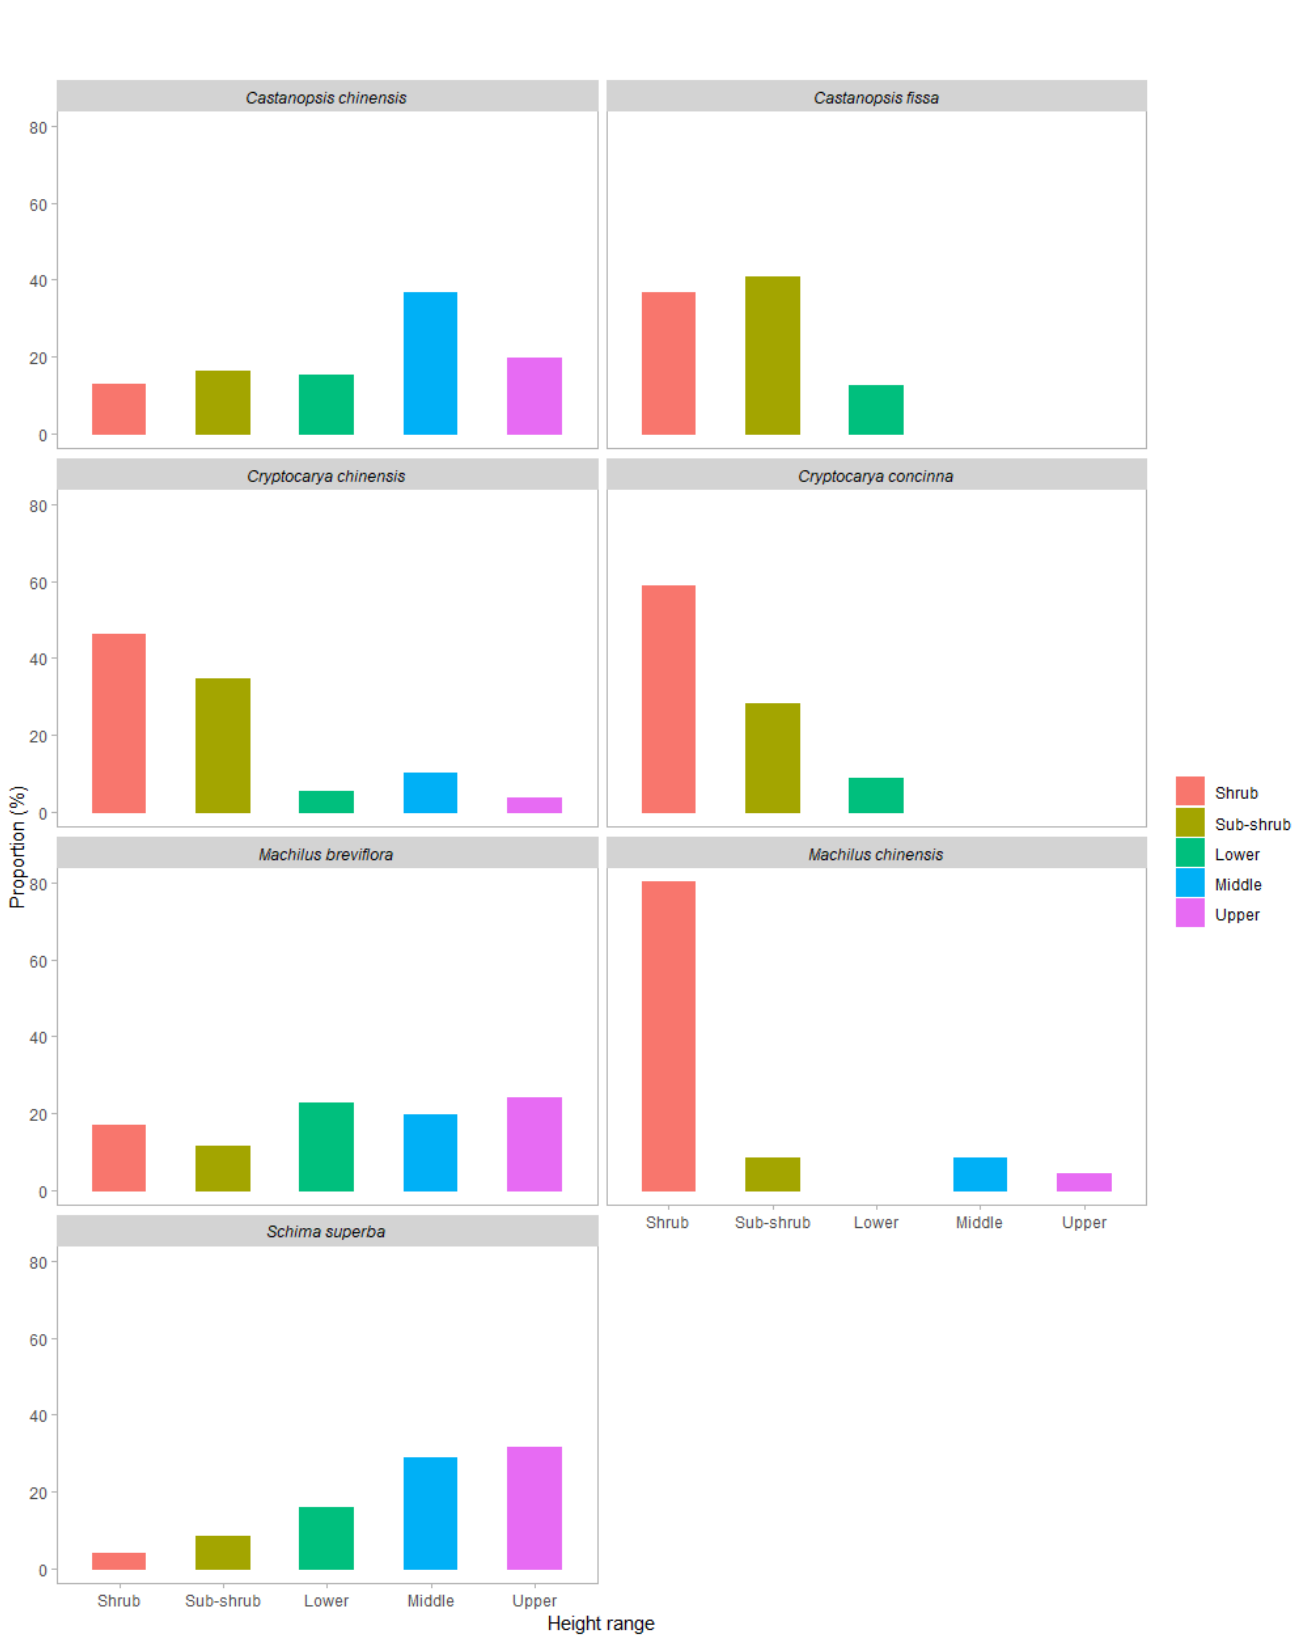
Figure A3. Proportion of each target species in different height ranges. The five height ranges were